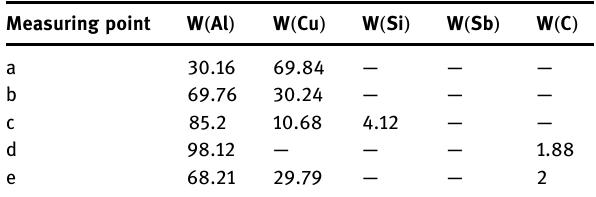
crystal planes of Cu Al are marked by calibrated di ff raction 9 4 points. The interplanar distances between the two planes are ( 310 ) = 1.919 nm, dCu ( 660 ) = 1.025 nm, and Al dCuAl 2 9 4